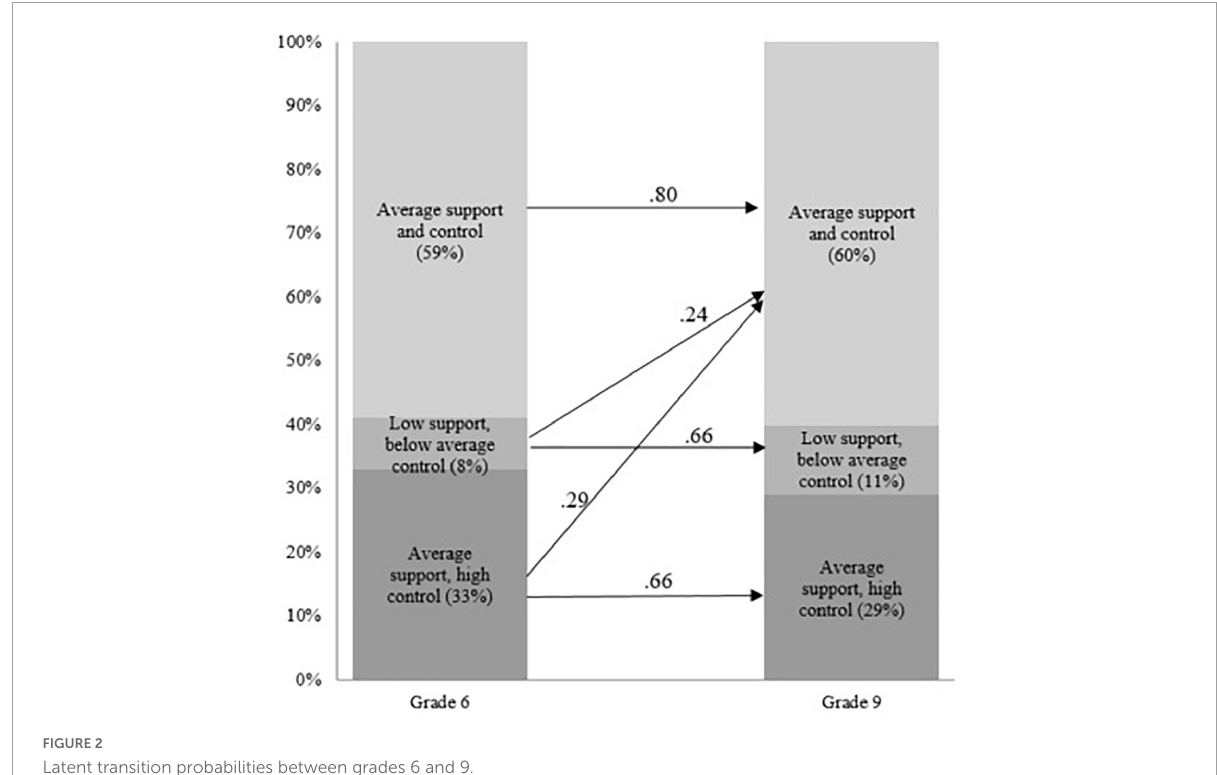
FIGURE2 Latent transition probabilities between grades 6 and 9.